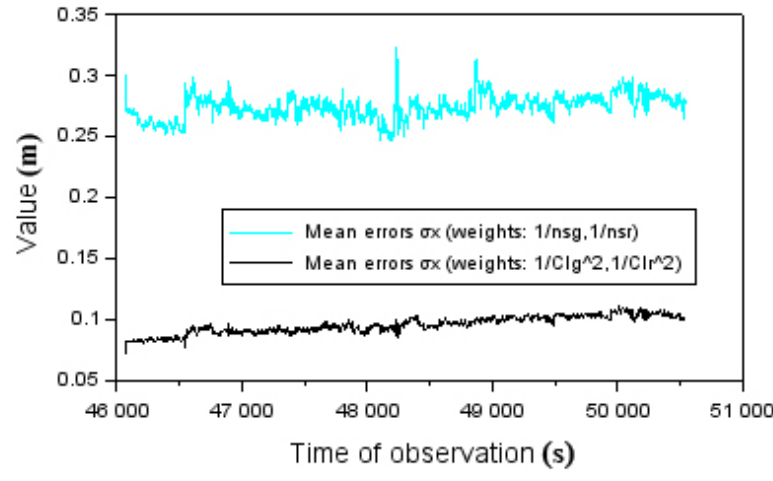
σ along the X -axis. x